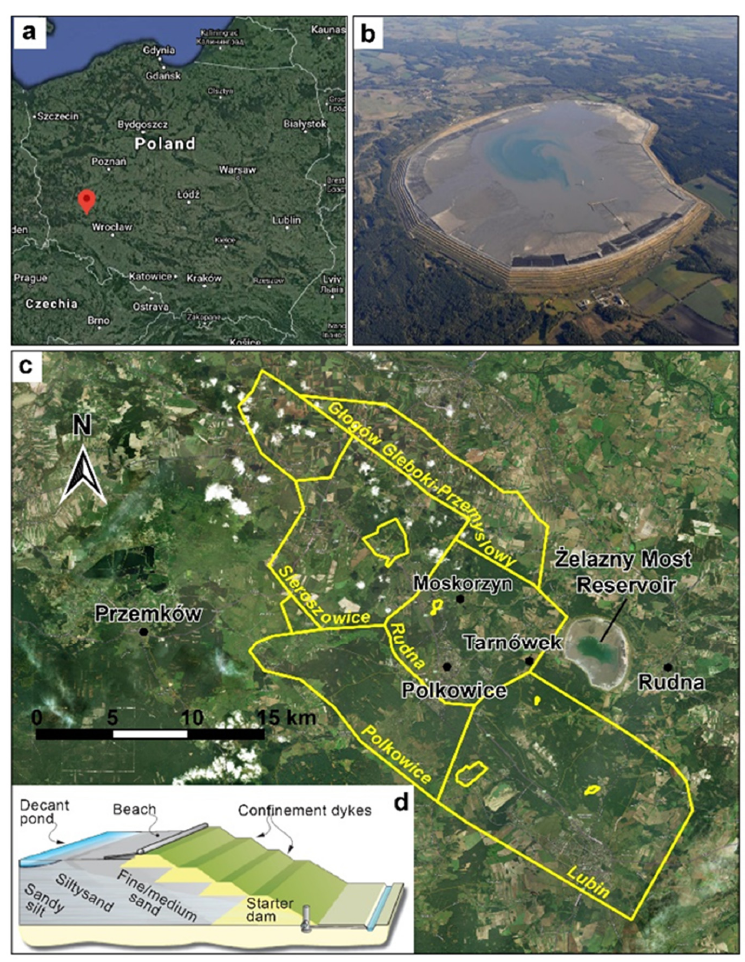
Figure 1. Ż elazny Most Tailings dam and adjacent Legnica Glogow Copper District (LGCD); ( a ) location of the study area; ( b ) aerial photo of Ż elany Most; ( c ) location of the tailings dam and borders of LGCD mines in yellow (from http://dm.pgi.gov.pl/, accessed on 2 May 2021); ( d ) schematic cross-sections of a ring dam (modified form [1], reprinted with permission from [1]. 2014, ICE Publishing).